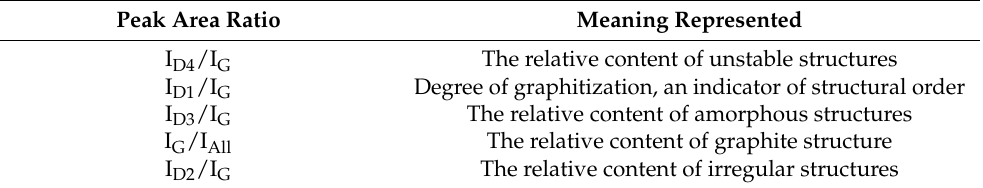
Table 7. Meaning of peak area ratio of characteristic peaks.